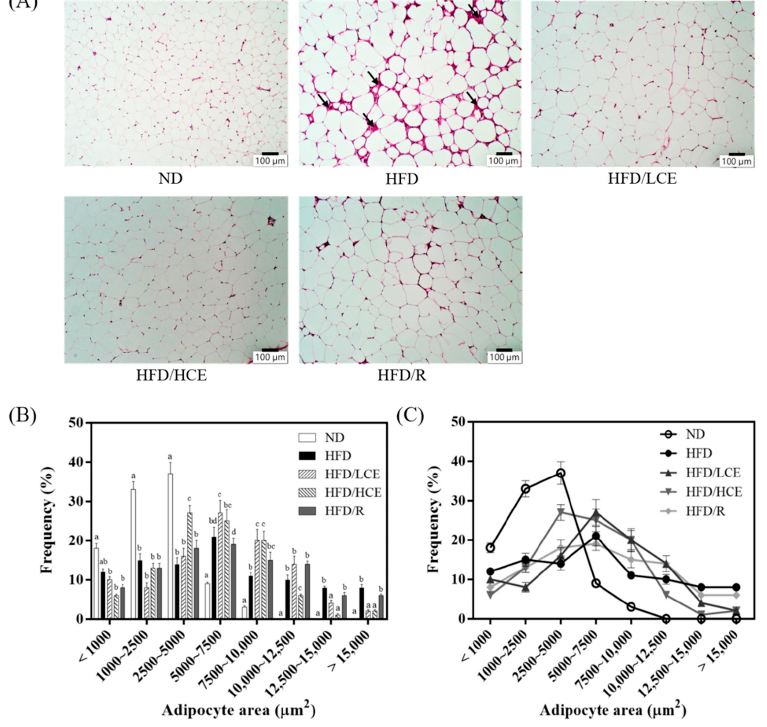
Figure 4. Effect of djulis hull crude extract on haematoxylin & eosin staining and adipocyte distri- bution of epididymal white adipose tissue (eWAT) in high-fat diet-induced hyperglycaemia. ( A ) Representative haematoxylin and eosin staining. Scale bar: 100 µm. ( B , C ) Adipocyte size and distri- bution of eWAT. ND: normal diet; HFD: high-fat diet; LCE: low dosage of crude extract; HCE: high dosage of crude extract; R: rutin. Values represent the mean ± SEM ( n = 6). The statistical methods used one-way ANOVA, and the values with different letters are significantly different at p < 0.05.